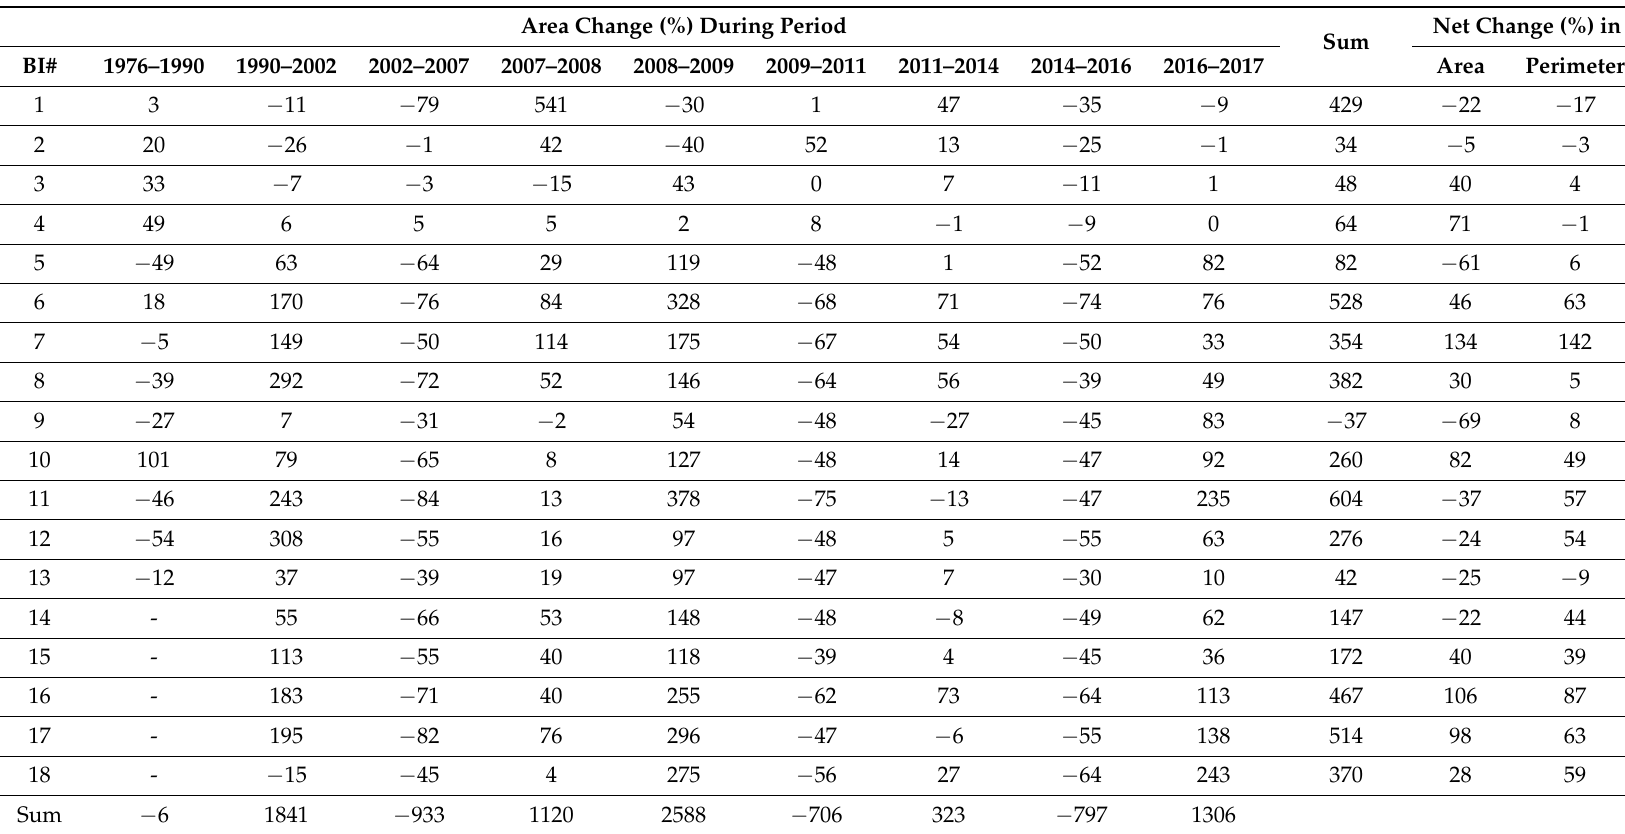
Table 1. Morphological changes in barrier islands with respect to area and perimeter from 1976 to 2017 in different temporal periods. Area Change (%) During Period